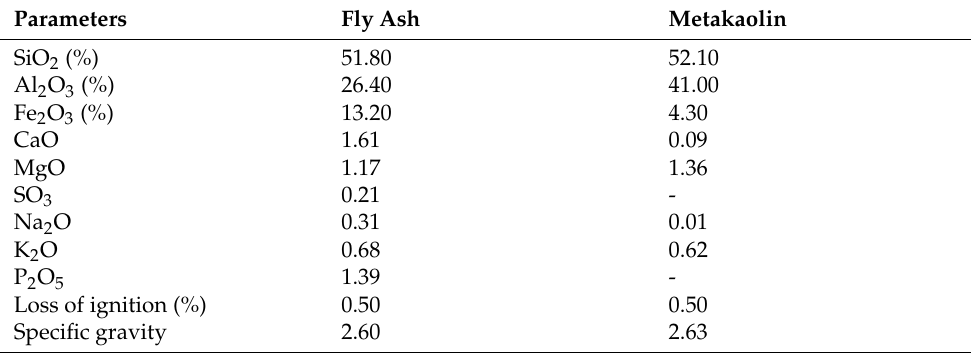
Table 1. Properties of fly ash and